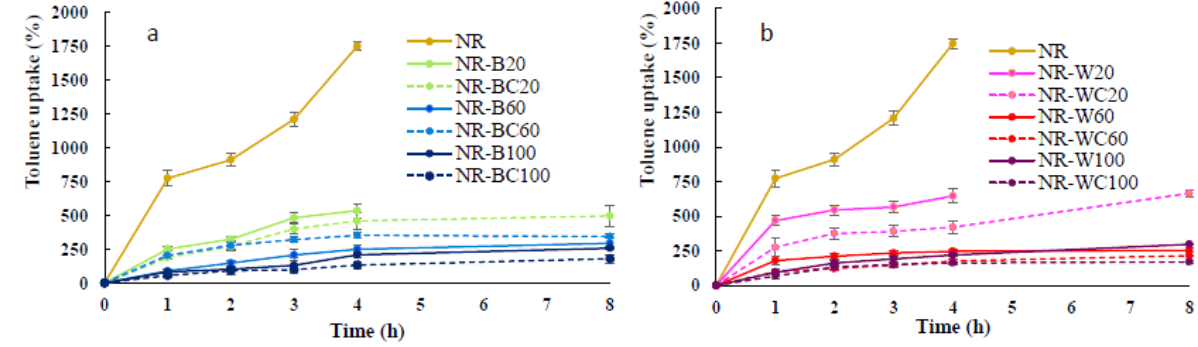
Figure 9. Toluene uptake of NR, NR–B, NR–BC ( a ) and NR–W, NR–WC ( b